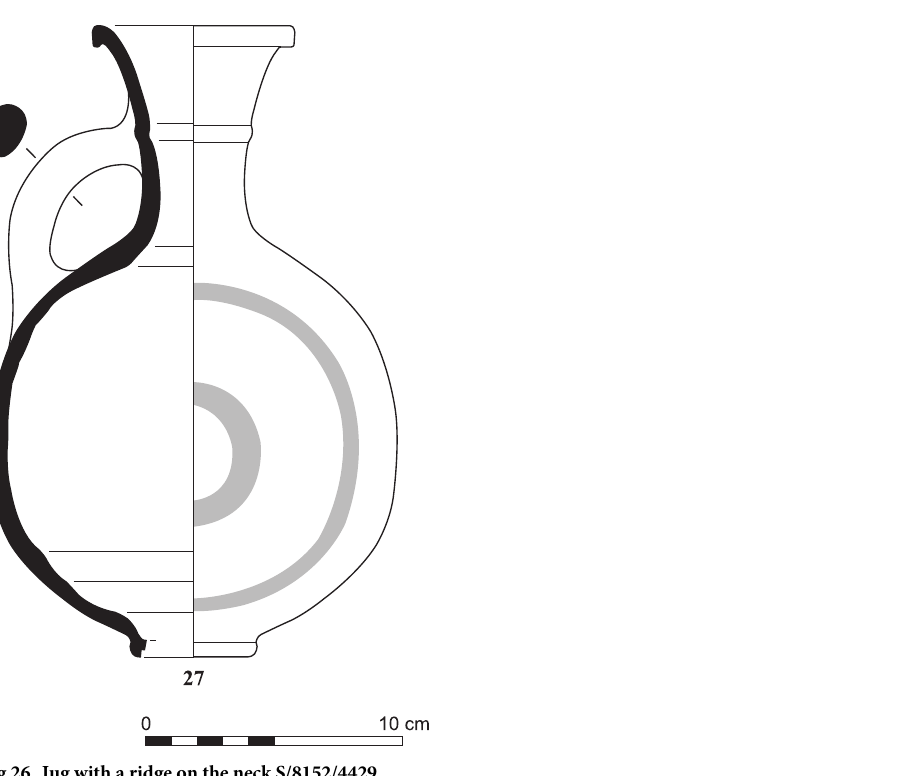
Fig 26. Jug with a ridge on the neck